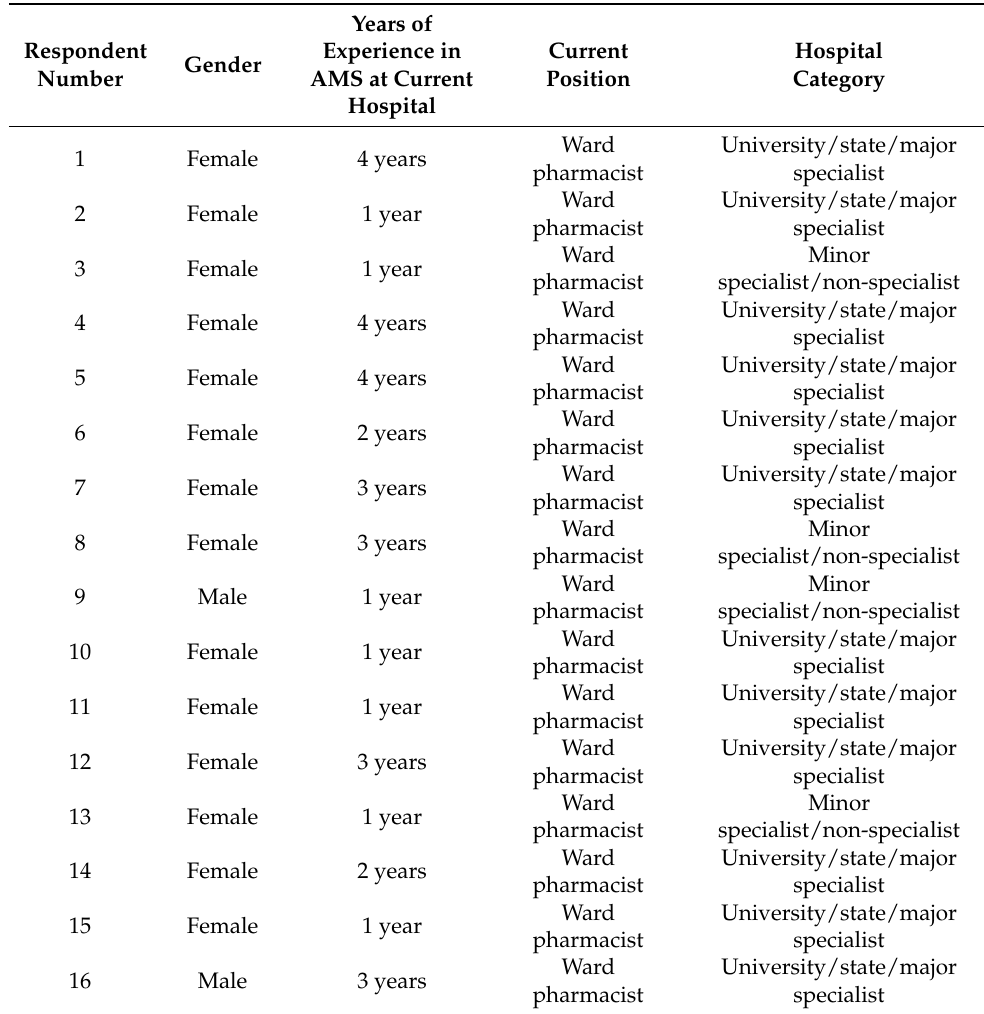
Table 1. Respondents’ demographic ( n =